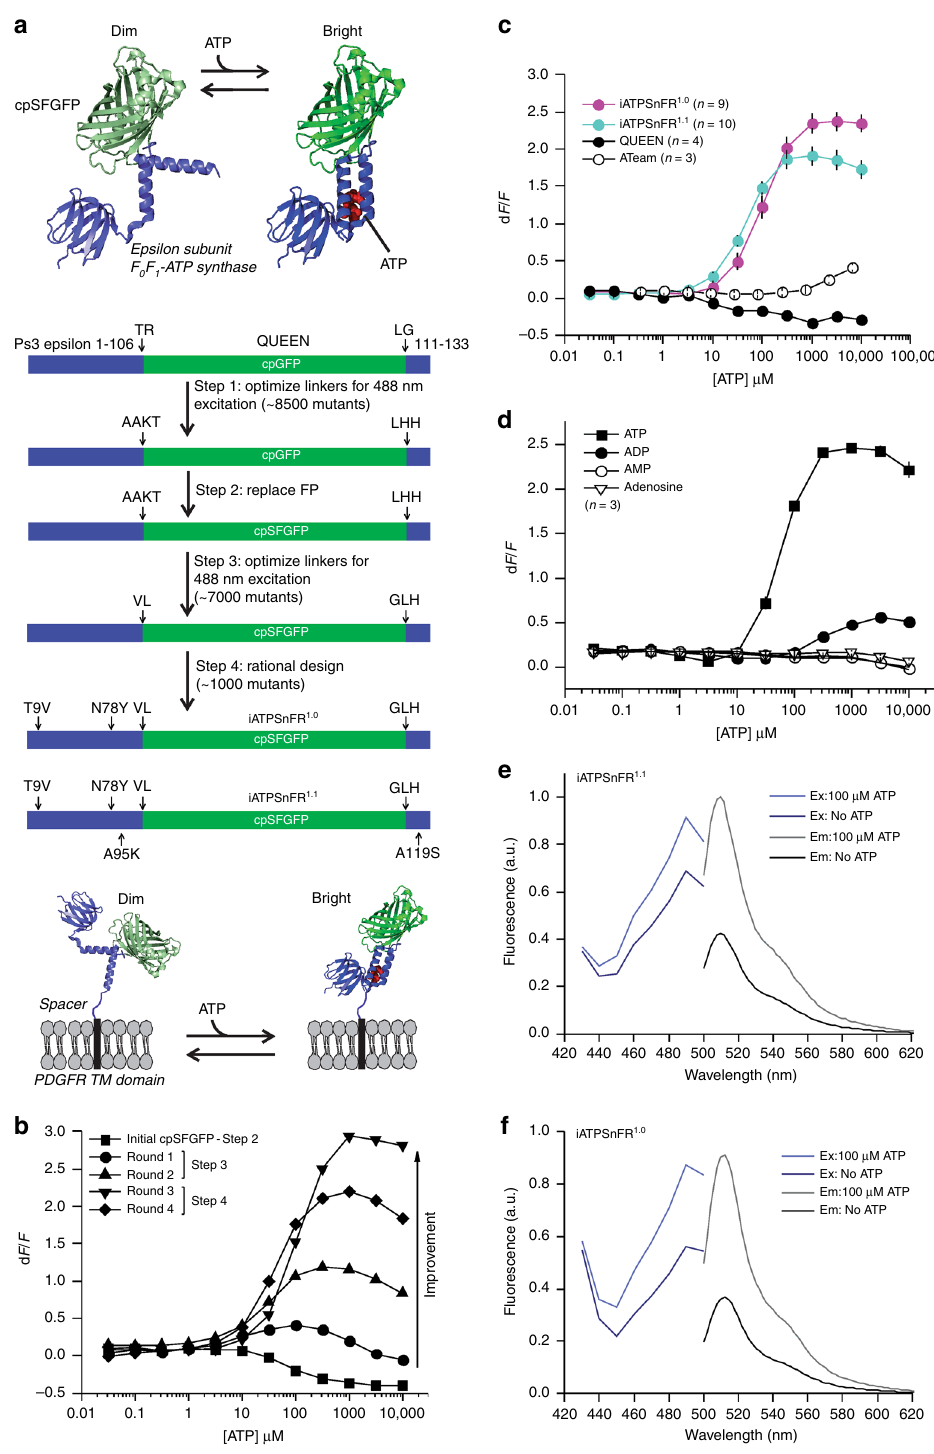
Fig. 1 Design and optimization of a single-wavelength ATP sensor. a Schematic showing the design and work fl ow used to optimize QUEEN-7 µ into a single- wavelength ATP sensor with the goal of displaying the sensor on the surface of cells. b Dose – response curves of iATPSnFR over several successive rounds of mutagenesis (Ex: 488 nm, Em: 515 nm). Fluorescence quenching at very high ATP concentrations can be observed in addition to binding-dependent increases. c Dose – response curves for puri fi ed ATeam, QUEEN-7 µ , iATPSnFR 1.0 , and iATPSnFR 1.1 . ATeam dose – response curves were acquired with Ex: 435 nm and Em: 530 nm. The other constructs were with Ex: 488 nm, Em: 515 nm. d Dose – response curves of puri fi ed iATPSnFR 1.1 to ATP, ADP, AMP, and adenosine. e , f Excitation and emission spectra for iATPSnFR 1.0 and iATPSnFR 1.1 in solution (the traces are the average from 48 replicates each in a 96-well plate). The error bars represent the s.e.m. and in some cases are smaller than the symbols used for the mean. When greater than one (in the case of exemplar traces and graphs), n is provided in the fi gure panels and refers to the number of independent